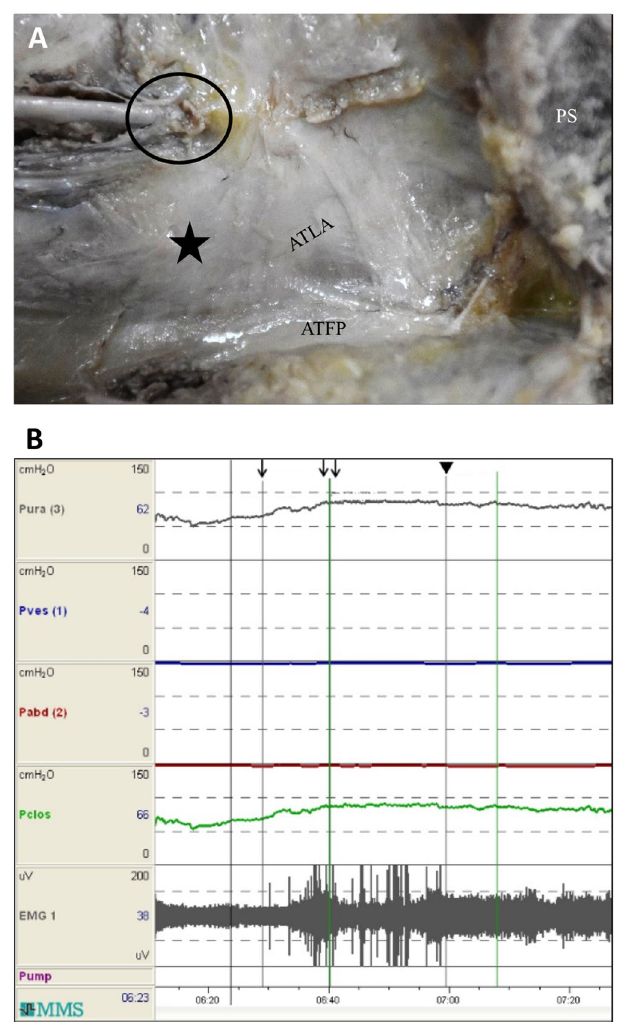
Figure 1. Electrode locations and electrophysiological changes in the levator ani muscle. ( A ) St. Mark’s disposable pudendal electrode was placed near the asterisk (*), which is near the posterior area of the obturator foramen above the arcus tendinous levator ani (ATLA). Detection patches were pasted at the bilateral perineal body near the anus. ( B ) Continuous cystometric and electromyogram (EMG) measurements obtained during the muscle stimulation test. When a low-intensity electrical current (15 mA) was delivered to the obturator fascia (at the single arrow site), the EMG activity gradually increased tonic amplitude, and some spontaneous spikes appeared during this period; simultaneously, an increase was observed in urethral pressure (Pura) and urethral closure pressure (Pclos) channels. Conversely, no drastic change was observed in the channels of vesical pressure (Pves) and abdominal pressure (Pabd). Subsequently, the electrical current intensity was increased to 30 mA (at the double arrow site), the tonic EMG and the rising pressures of Pura and Pclos immediately reached a plateau. The period of pressure plateau gradually decreased after the stimulation current was stopped (at the arrowhead site). The obturator canal is labeled by a circle. ATFP arcus tendineus fasciae pelvis, PS pubic